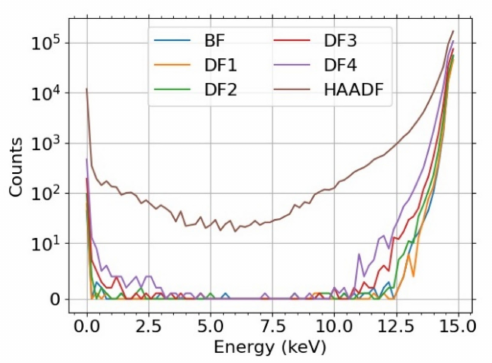
Figure 4. C 100 nm, 15 keV, glassy-carbon, MC for 10 6 electrons. The visualization uses a symlog scale with the linear threshold equal to